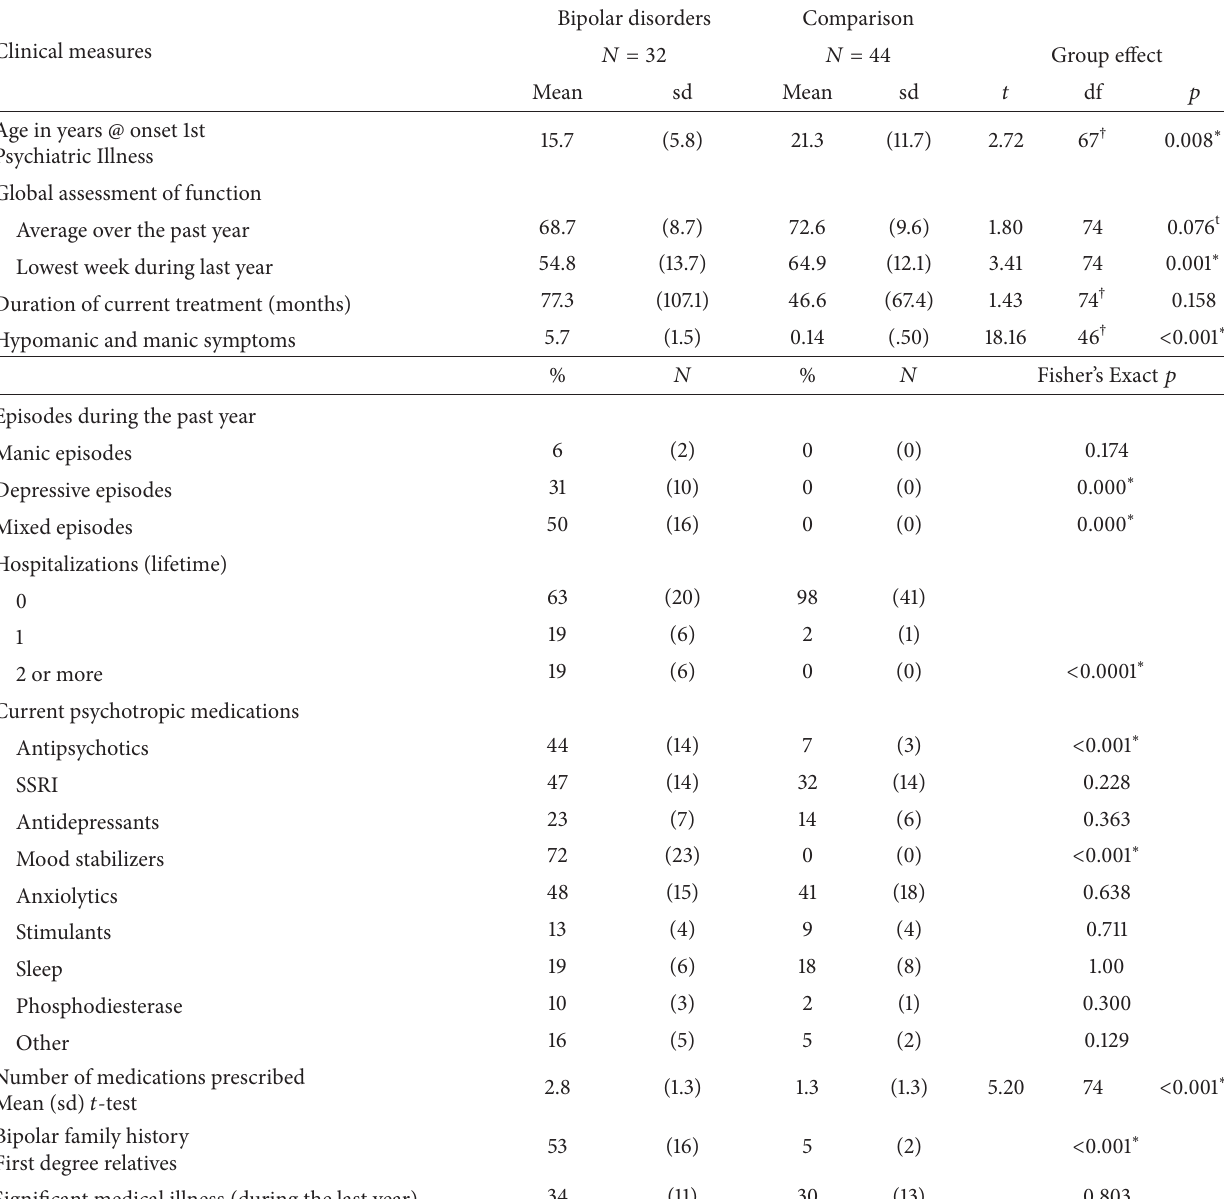
Table 2: Psychiatric history and clinical